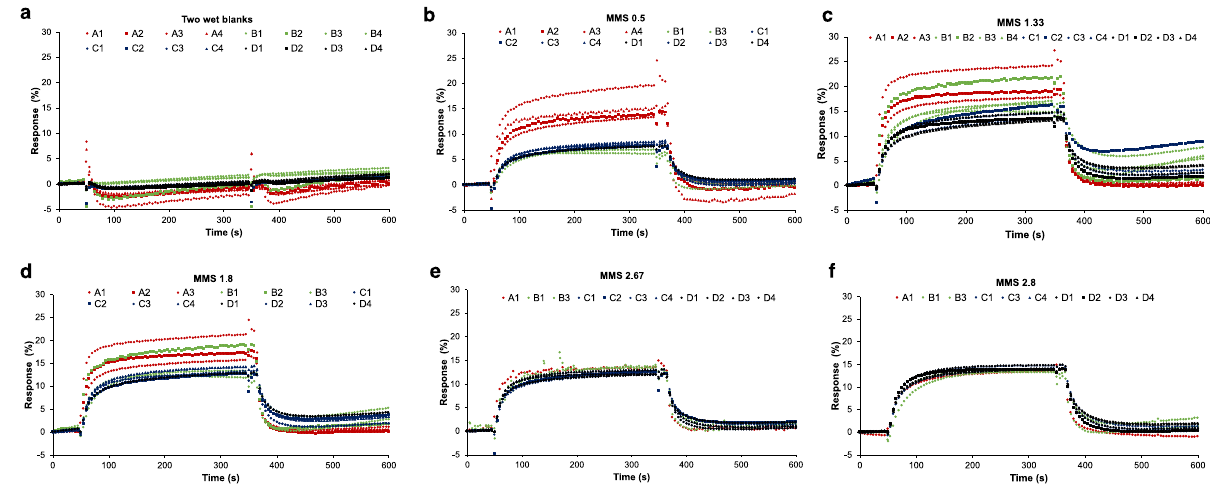
Fig. 3 | Sensor responses to various fabric swatches. a Wet blank swatch fabrics. b – f Malodour swatch fabrics from different MMS values. A – D refer to four different types of OFET devices, and multiple sensors of the same type are used in the